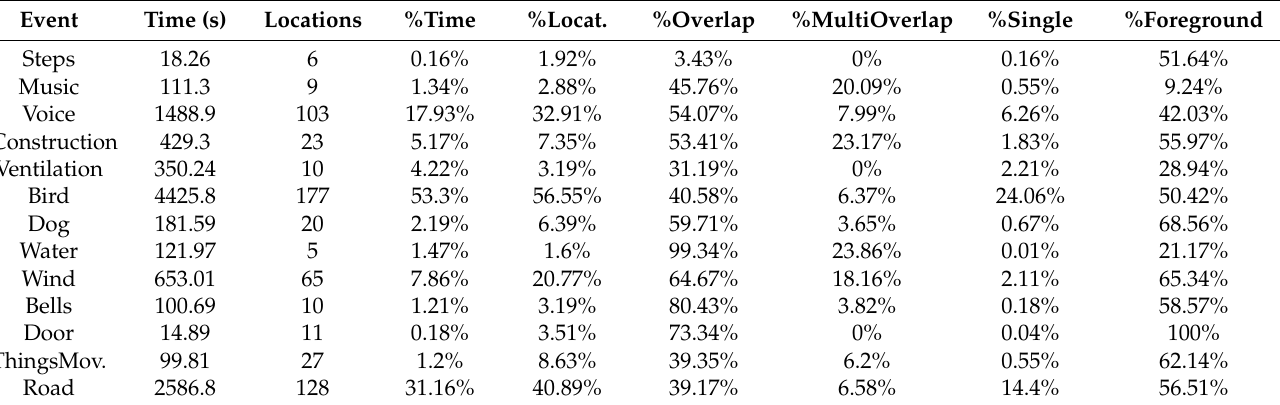
Figure 3. Number of classes by prevalence (% of total time where they appear) and campaign. Classes appearing in less than four locations have been discarded. Table 1. Dataset’s internal statistics for the 2020 campaign (only fine labels appearing in 4 locations or more).